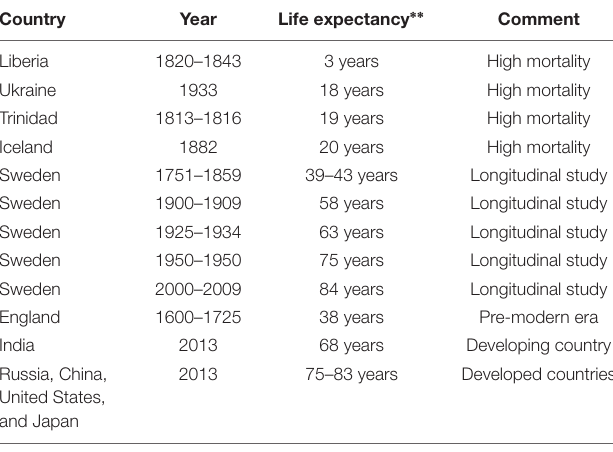
TABLE 1 | Life expectancy according to time and location in the world for human populations ∗